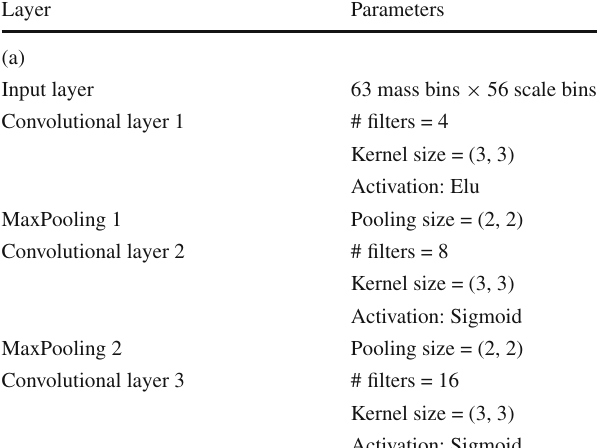
Fig. 5 Example of the region finder algorithm input and output. a The input, which is the norm of the CWT divided by the expectation value of the background. b The output, which is trained to be | W s , exp | / (cid:7)| W b |(cid:8) . Table2 (a)Structureoftheconvolutionalneuralnetworkofthewavelet classifier. (b) Training parameters. All parameters not specified in these tables are left at their default Keras values